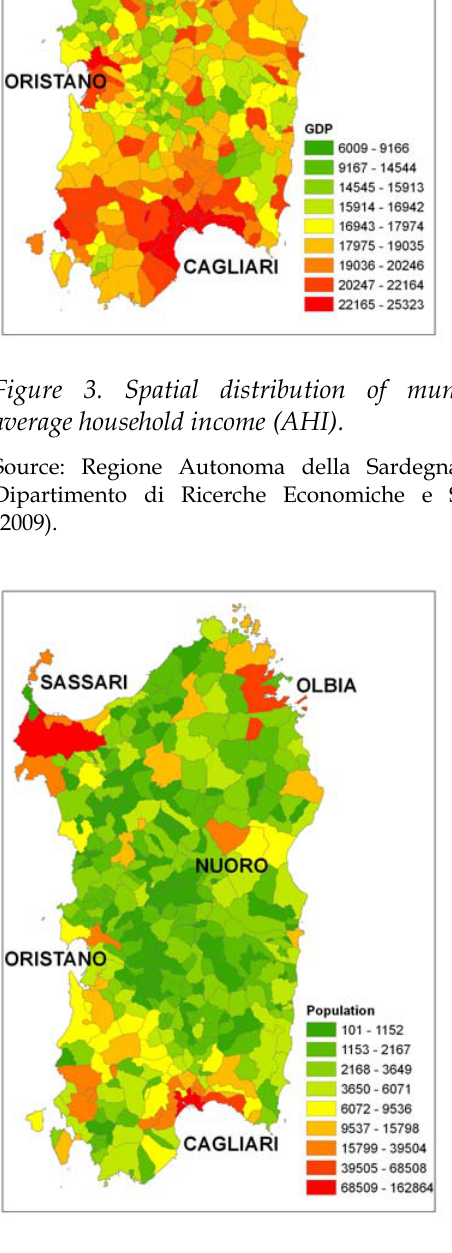
Figure 6. Spatial distribution of municipal resident population. Source: Istat (2001).